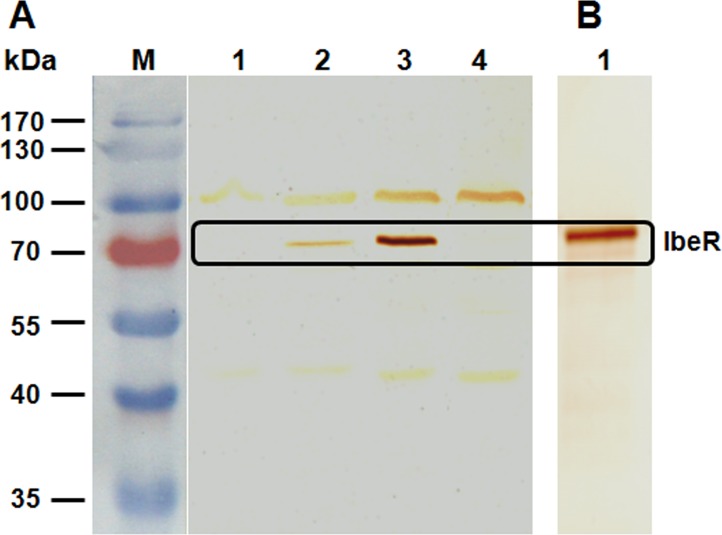
Expression of IbeR by Western blotting.
(A) Immunoblotting with anti-IbeR of total cell lysates from different APEC strains. Expression of IbeR was detected in wild-type strain DE205B and complementation strain CΔibeR, but not mutant strains ΔibeR or PΔibeR. Lane M, prestained protein marker; Lane 1, ΔibeR (ibeR negative); Lane 2, DE205B (ibeR positive); Lane 3, CΔibeR (ibeR positive); Lane 4, PΔibeR (ibeR negative). (B) Immunoblotting of purified IbeR protein using anti-DE205B. Incubation with anti-DE205B detected protein bands of the expected size for purified IbeR protein. Lane 1, anti-DE205B.